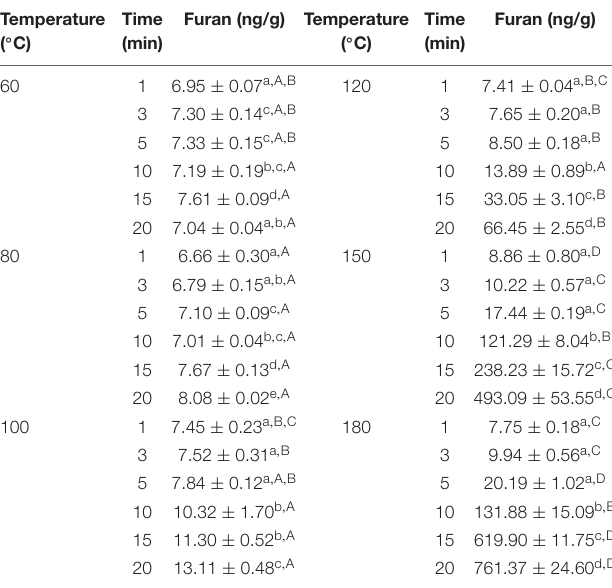
TABLE 2 | Furan concentration of roasted red pepper